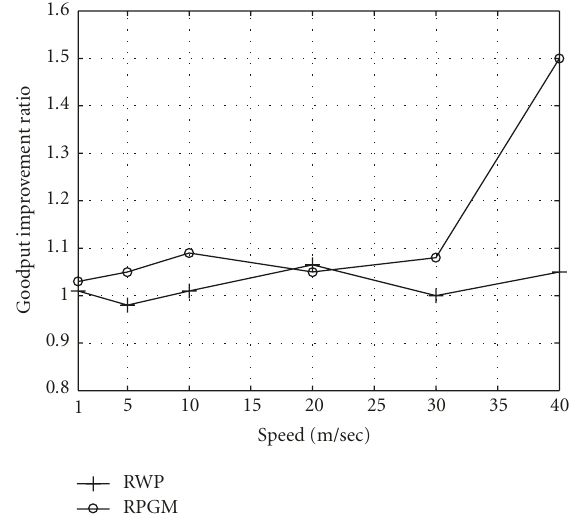
Figure 10: Goodput improvement ratio (Bypass-AODV/AODV) for di ff erent number of simultaneous TCP connections.